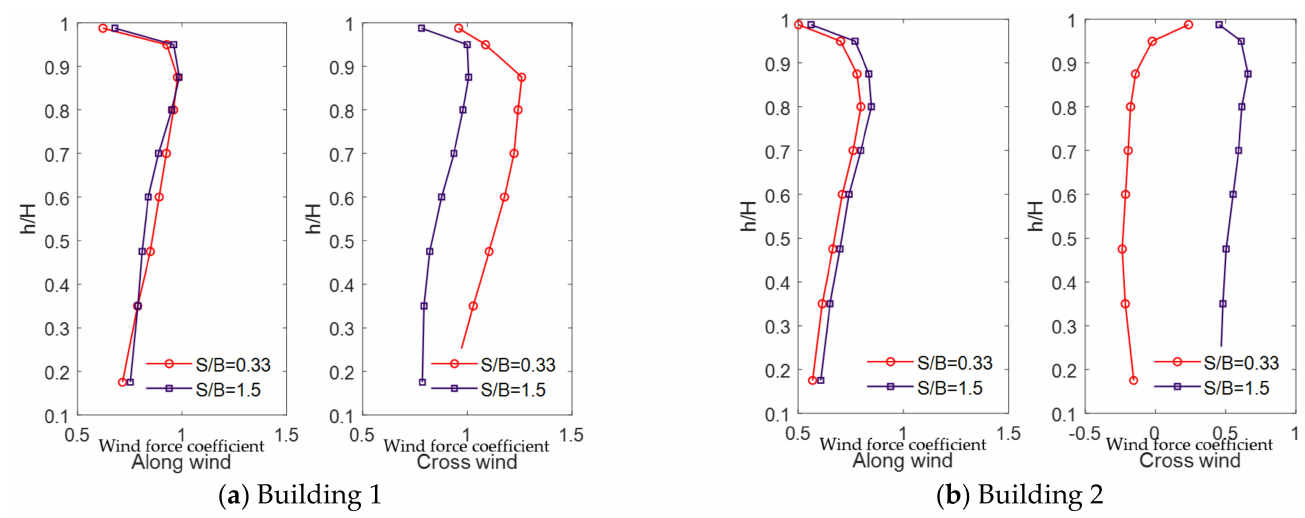
Figure 11. Mean values of local wind-force